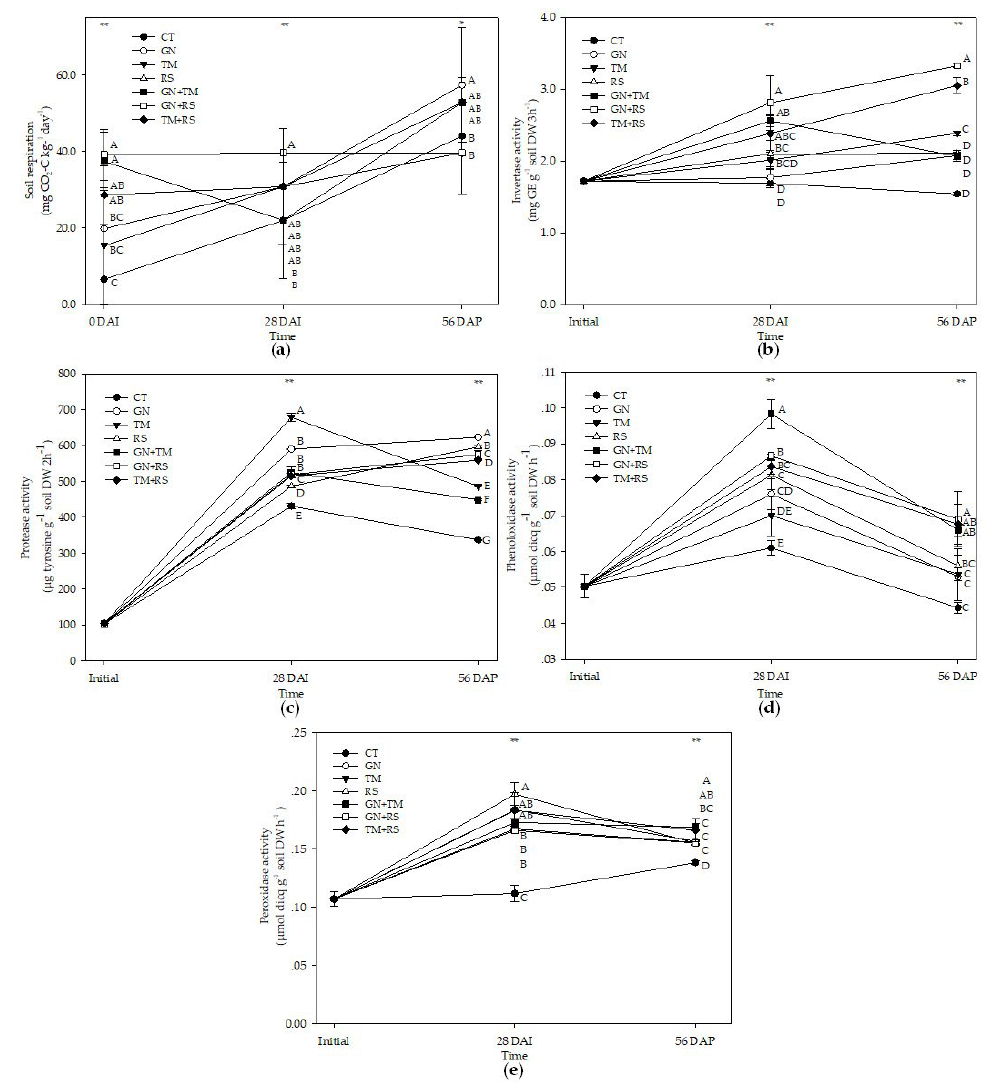
Fig. 2. Soil respiration (a), invertase (b), protease (c), phenoloxidase (d), and peroxidase (e) activity in soil treated with different quality organic (CT: untreated control, GN: groundnut, TM: tamarind, RS: rice straw, GN+TM: groundnut + tamarind, GN+RS: groundnut + rice straw, TM+RS: tamarind + rice straw). *, ** significantly different at p < 0.05, and 0.01,